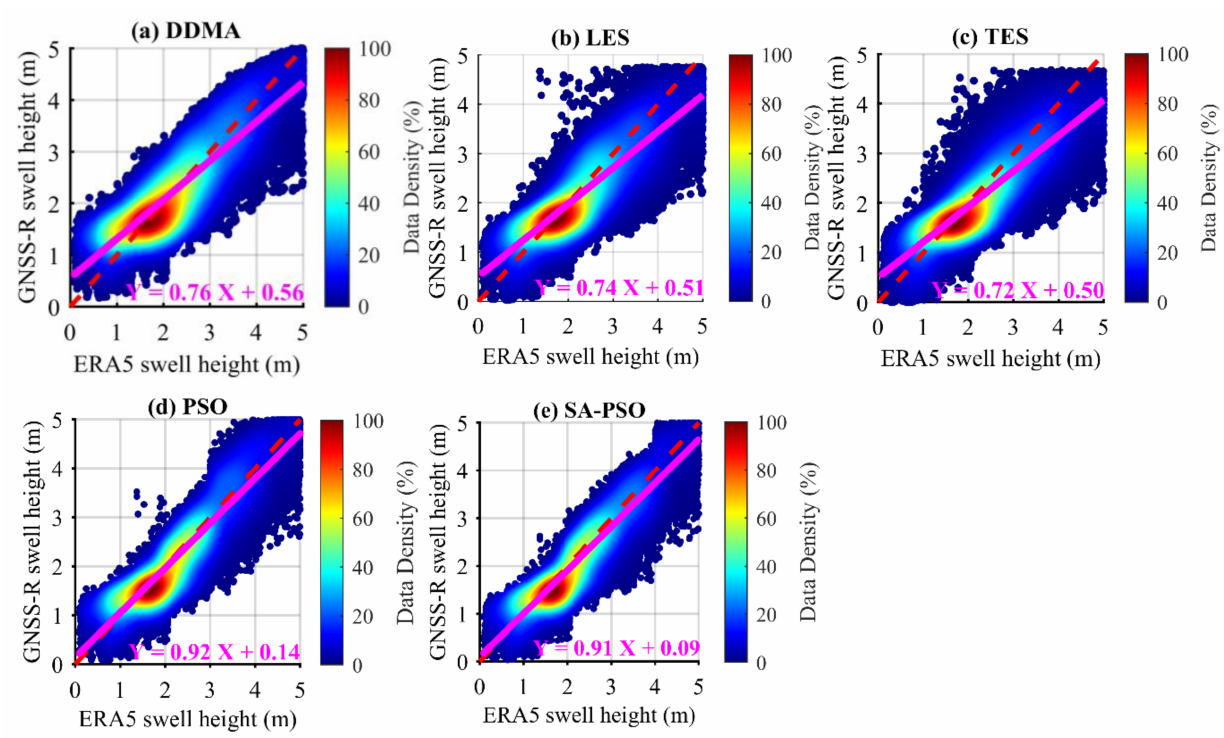
Figure 7. Scatter density plots of swell height estimates and ERA5 swell height data. The color bars indicate data density relative to the distribution peak (from cool to warm). The red dotted line represents the 1:1 reference line, while the magenta solid line represents the linear fitting results of swell height estimates by the GNSS-R method and ERA5 swell height data. ( a ) DDMA observable,